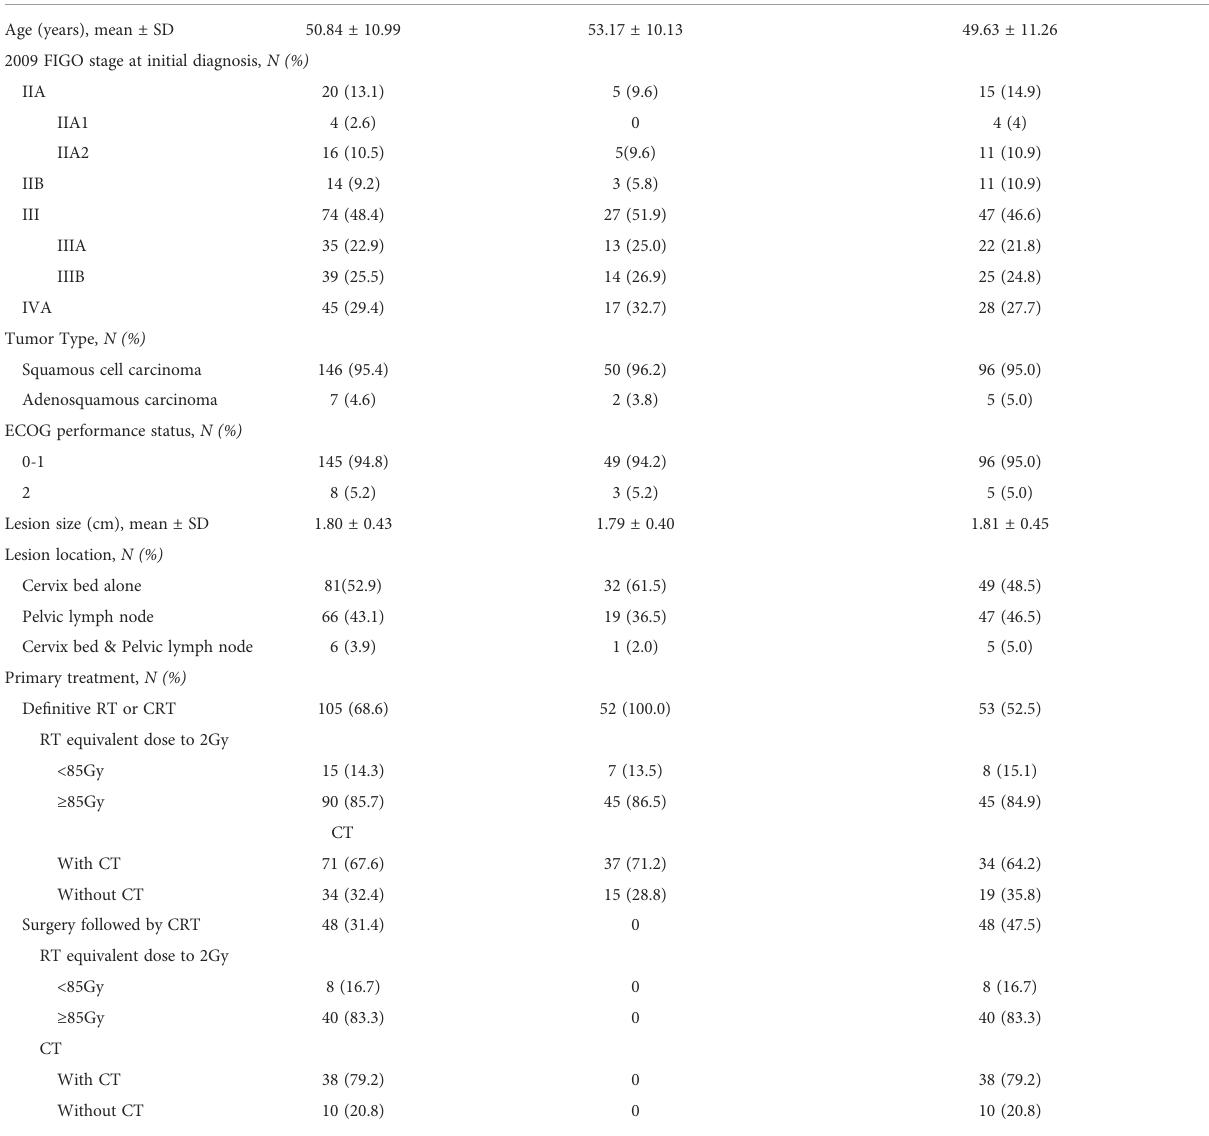
TABLE 1 Clinical characteristics for the cervical cancer patients prior to HIFU treatment.